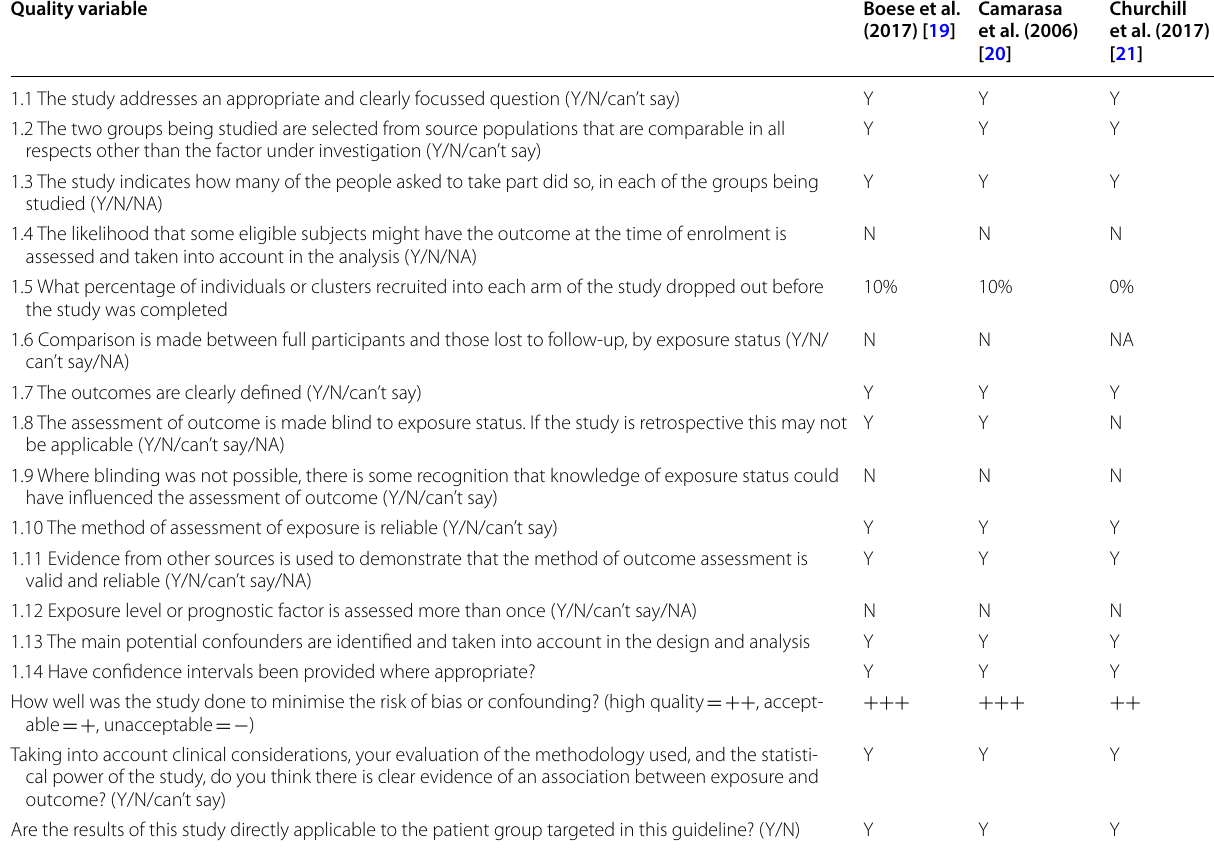
Table 1 Methodological quality of prospective studies included, adapted from the Scottish Intercollegiate Guidelines